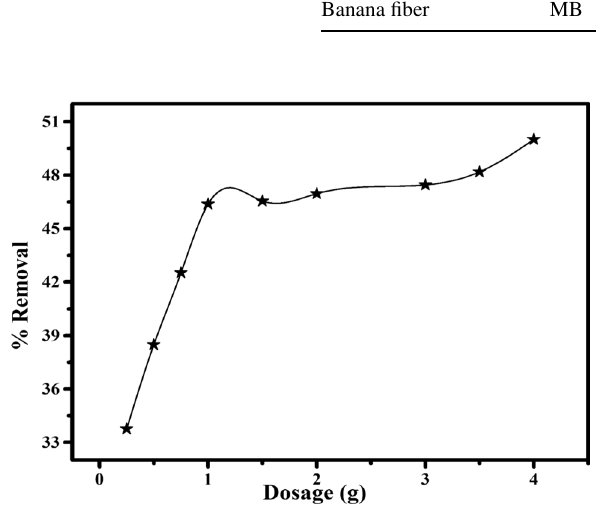
Table 2 Comparison of different low-cost adsorbents with removal percentage at operating pH